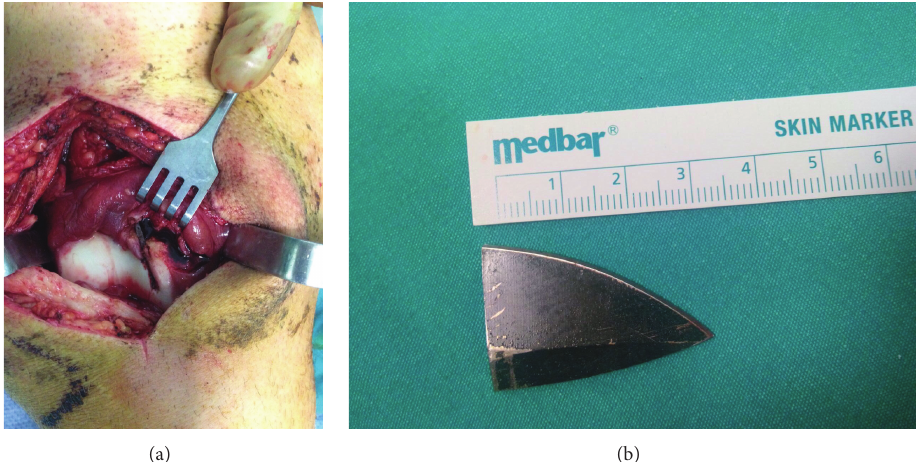
Figure 2: (a) Intraoperative appearance of the knifepoint. (b) Postoperative appearance of the